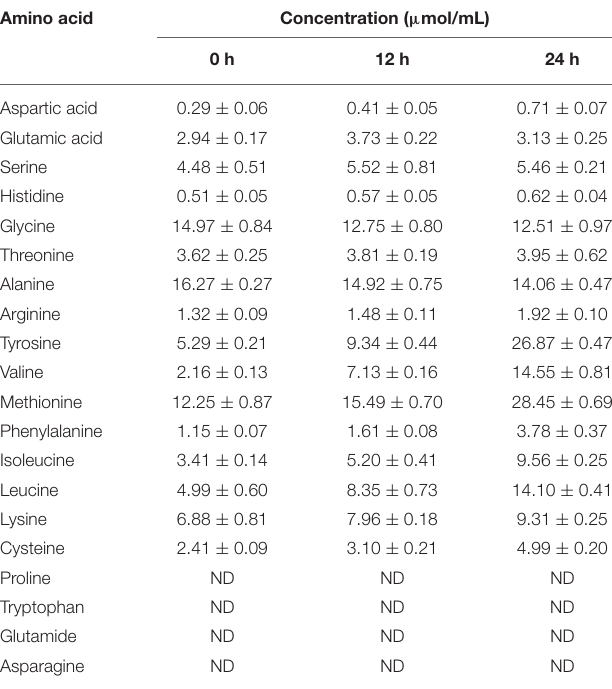
TABLE 3 | The concentration of amino acids detected in feather hydrolysate after 12 and 24h of degradation. Amino acid